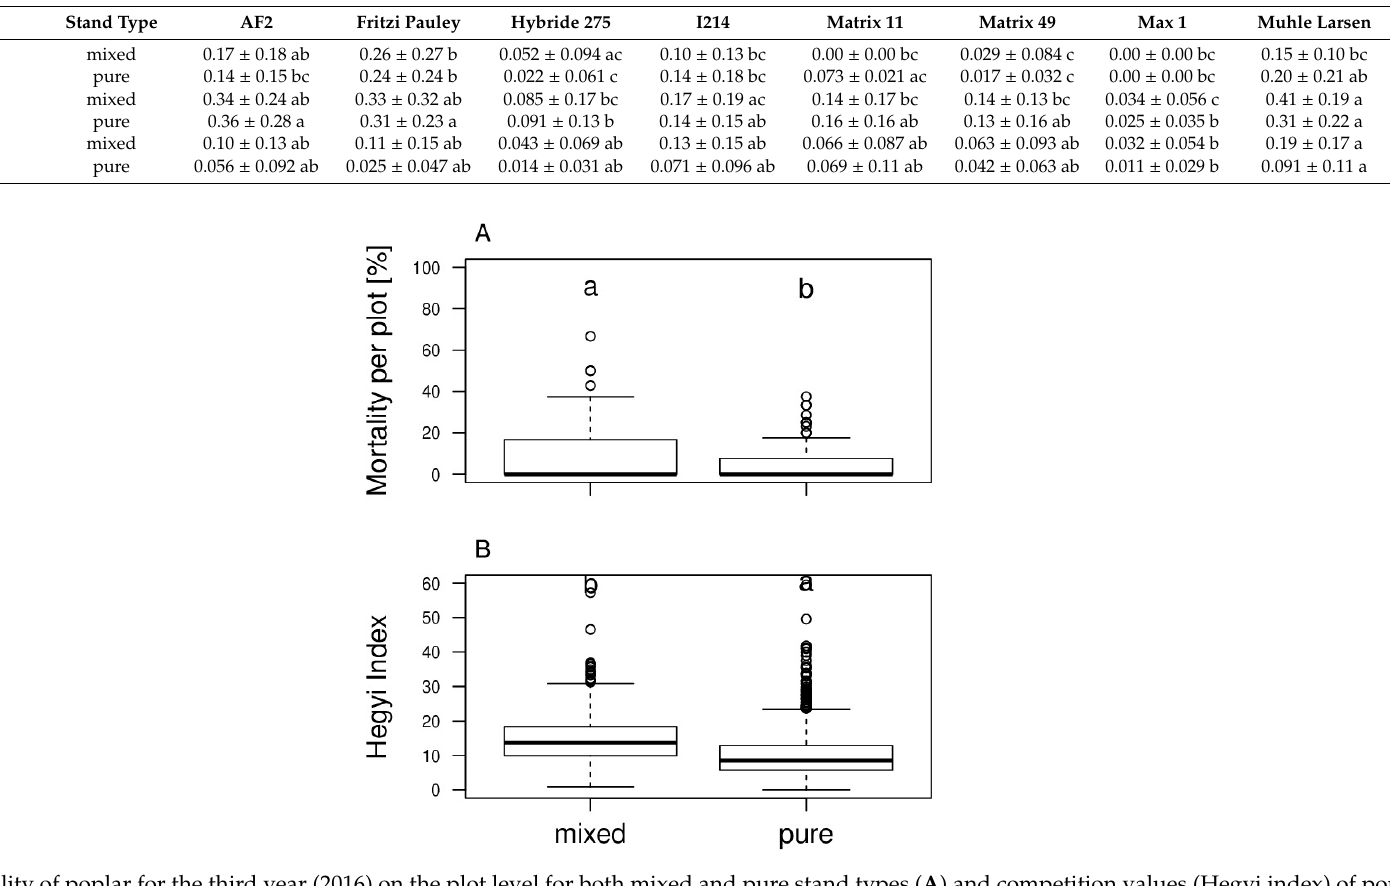
Table 2. Analyses of variance (ANOVA), mean, and standard deviation at plot level for mortality proportion of all poplar genotypes. The letters represent the results of Tukey post-hoc comparisons between genotypes means ( p -value < 0.05).